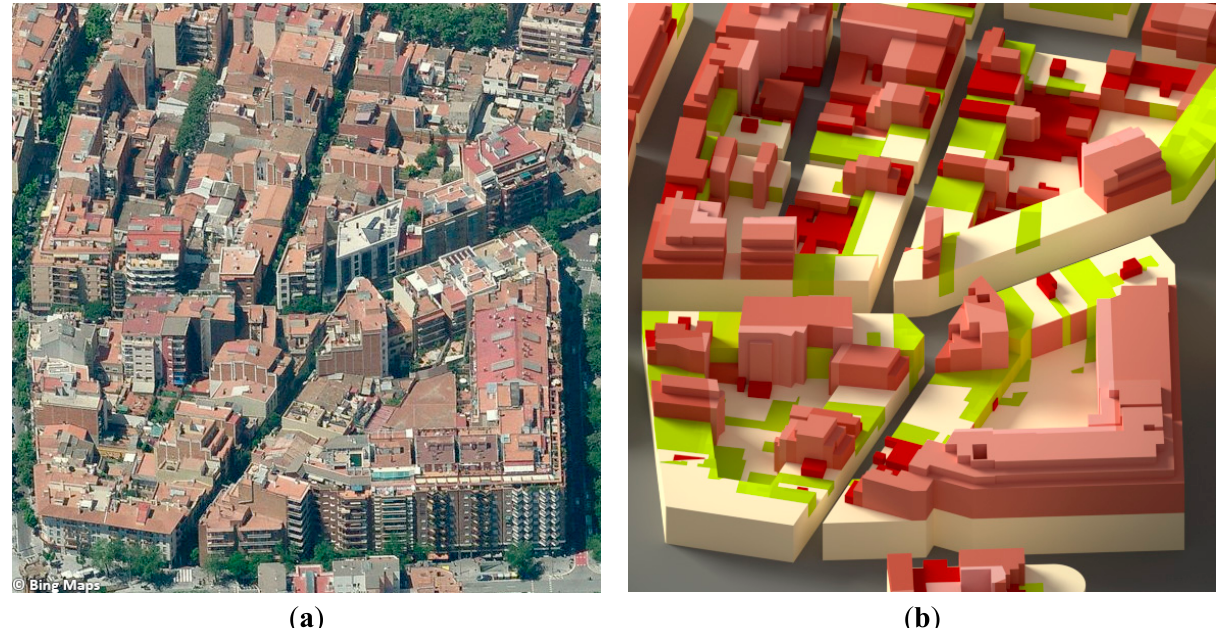
Figure 15. ( a ) Aerial axonometric view (Bing Maps) and ( b ) 3D representation of the same